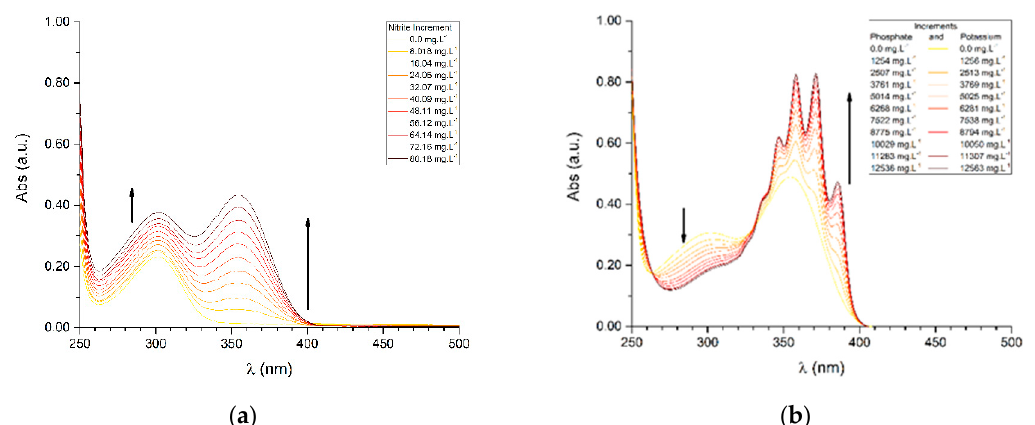
Figure 4. Examples of UV-Vis spectra where ( a ) linear correlation was observed (Test A2) and ( b ) logarithmic correlation was observed (Test D2). logarithmic correlation was observed (Test